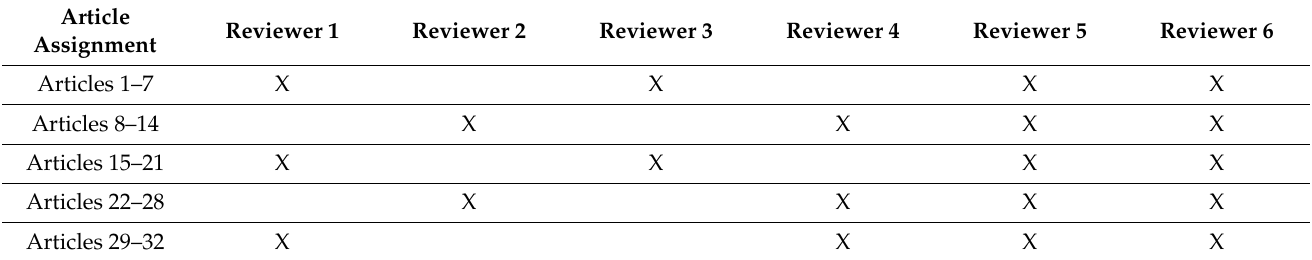
Table 1. Reviewer assignment of the initial database search findings (full article